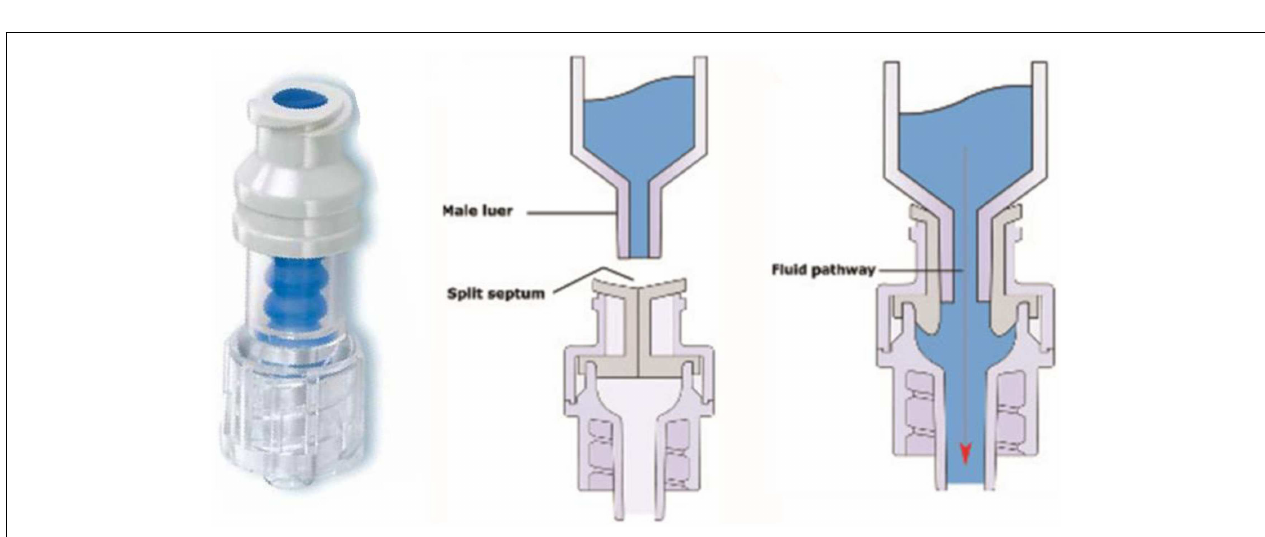
FIGURE 3 | (A) Intervention: arterial line in the closed catheter access system. 1. Intravascular cannula, 2. Extension tube luer lock, 3.Three-way stopcock luer lock, 4. Needleless connector, 5. Heparin saline in luer lock